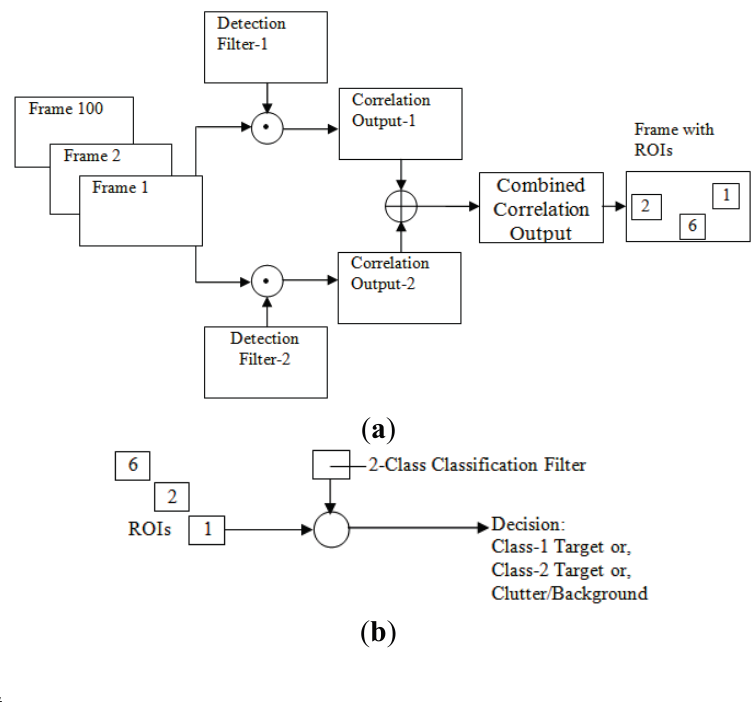
Figure 1. Schematic diagram of the proposed technique for ( a ) detection stage; and ( b ) classification